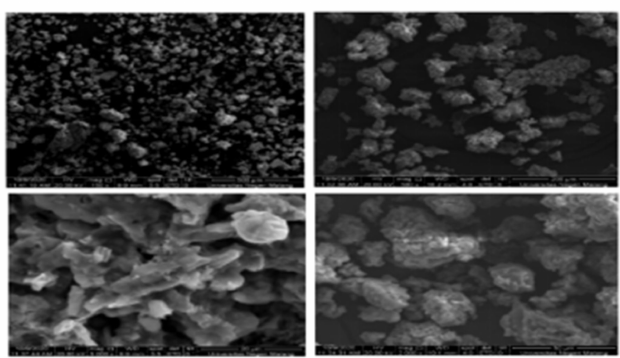
Figure 18. SEM image of ZnCr 2 O 4 /CNS composite from pyrolysis of rice husk.